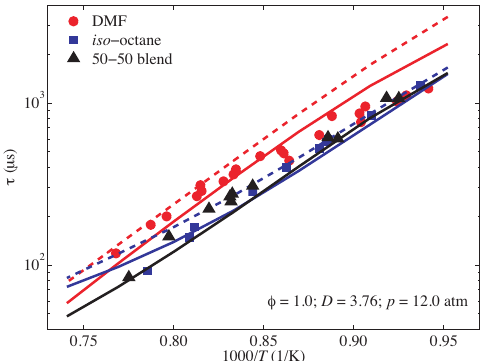
Figure 10. Experimental ignition delay times compared with model predictions for stoichiometric 2,5-DMF, iso -octane mixture and 50-50 blends at 12.0 atm, as shown in Eldeeb and Akih-Kumgeh [25]. Solid lines: blend model. Dashed lines: original 2,5-DMF and iso -octane models